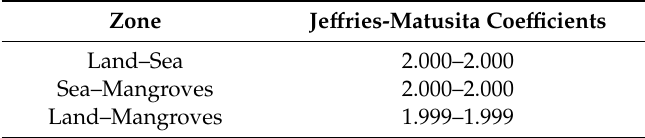
Table 3. ROI matrix separability, for the SENTINEL-2 imagery, using Je ff ries-Matusita